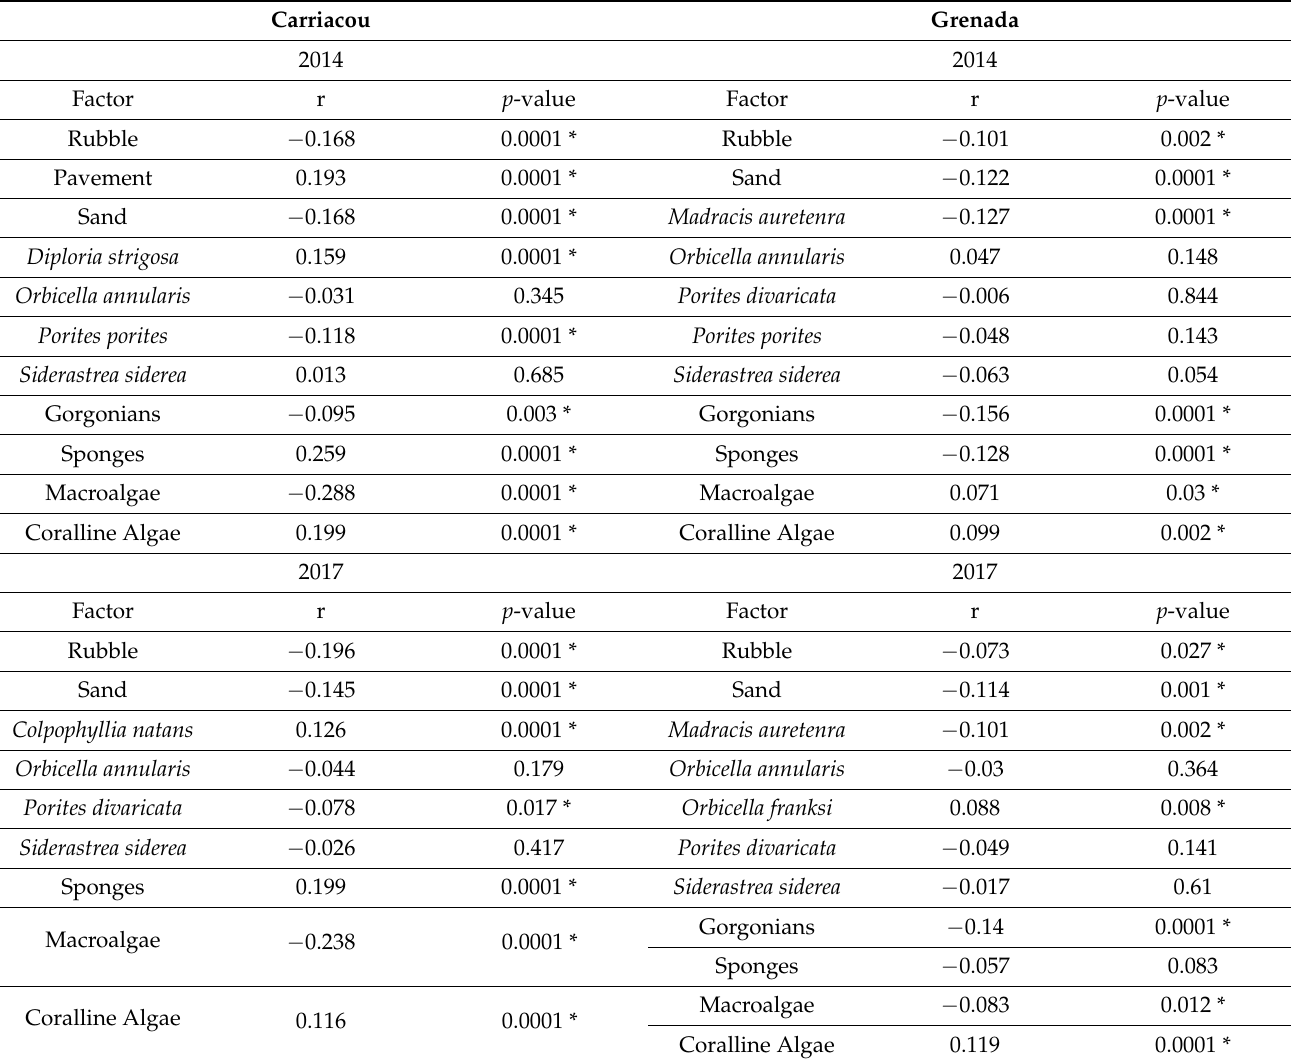
Table 4. Magnitude of the relationship between P. astreoides , scleractinian coral species, biotic factors, and habitat type. Pearson correlation coefficients indicated by r. * Indicates significance at p =